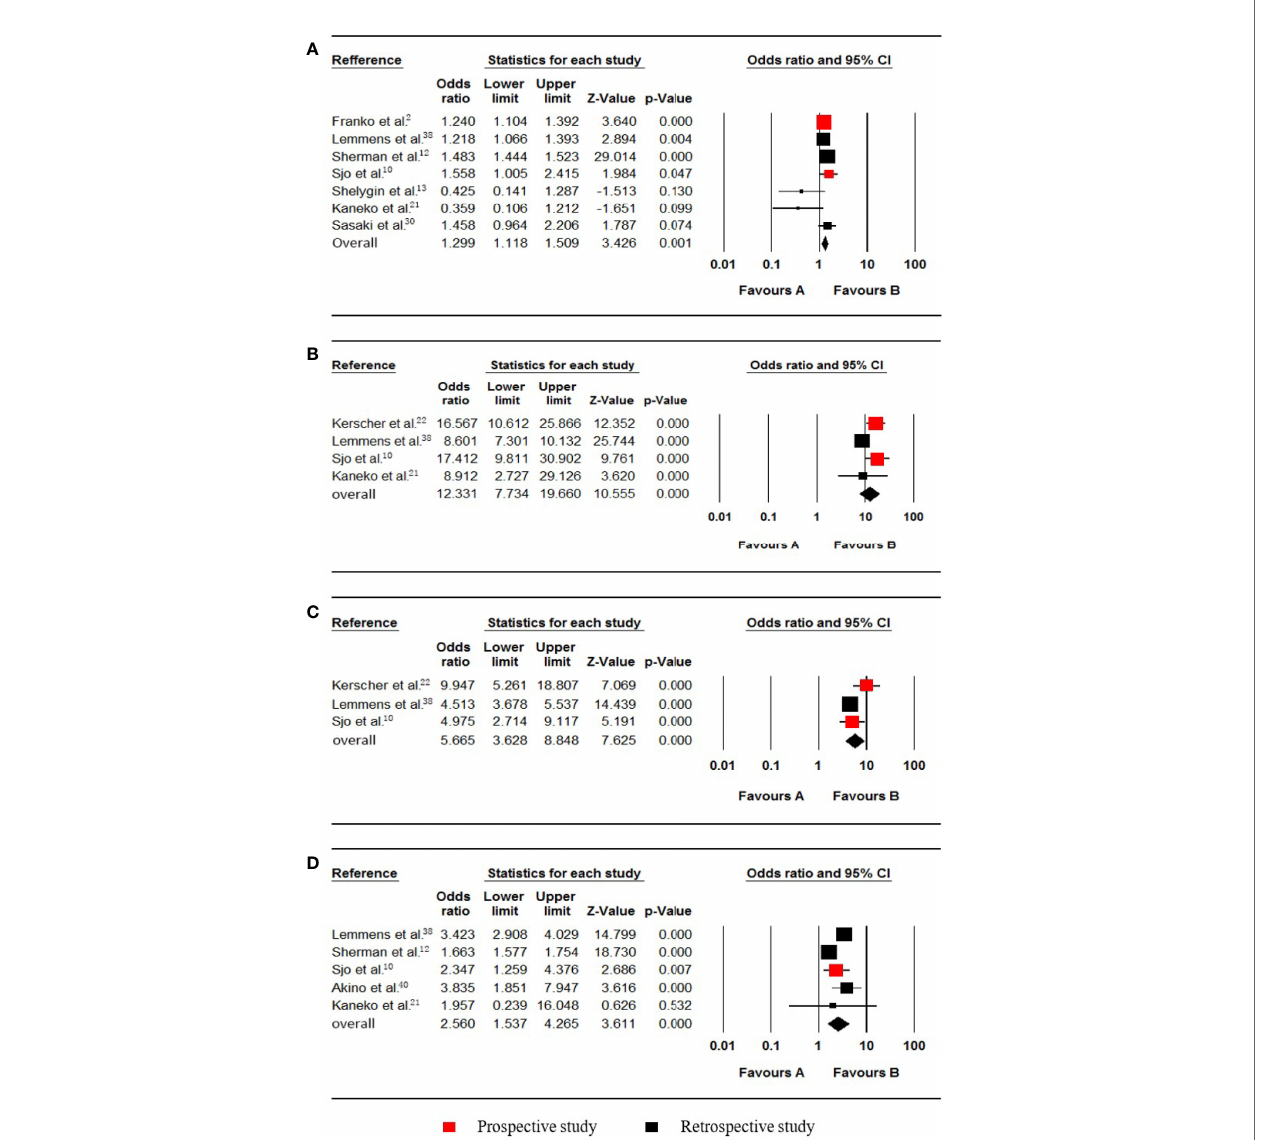
FIGURE 2 | Forest plot for females, T4, N1-2 and poorly differentiated grade. Favours A, non-pmCRC. Favours B, synchronous pmCRC. (A) female. (B) T4. (C) N1- 2. (D) poorly differentiated